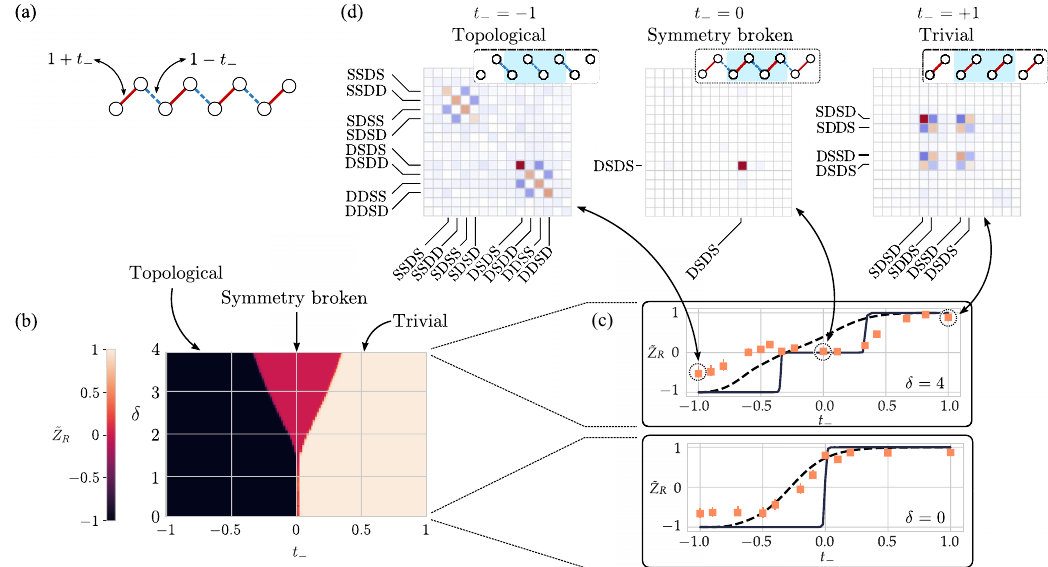
FIG. 2. (a) Sketch of the ESSH model for N ¼ 8 sites, with neighboring sites connected by alternating coupling strengths 1 (cid:3) t − ˜ Z denoted by solid red and dashed blue bonds. (b) Partial-reflection MBTI R Eq. (7) calculated numerically for a system of infinite size N → ∞ and n ¼ 100 using the infinite-size density matrix renormalization group technique [11]; labels give the phases of the ESSH model. (c) Comparison of numerical values of MBTIs for a finite-sized system (dashed), the thermodynamic limit (solid), and the experimentally obtained data (square markers) for δ ¼ 0 (bottom) and δ ¼ 4 (top). (d) Real component of the reduced density matrices ˜ Z for the four central ions at δ ¼ 4 and t − ∈ f − 1 ; 0 ; þ 1 g . The corresponding data points of R are indicated by